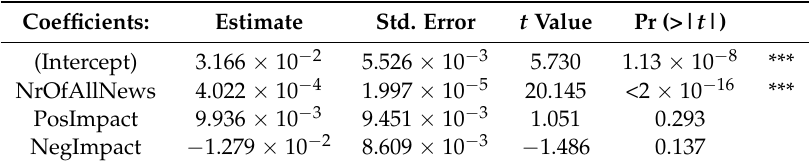
Regression analysis for volatility of the mean bond spread difference from Italy.